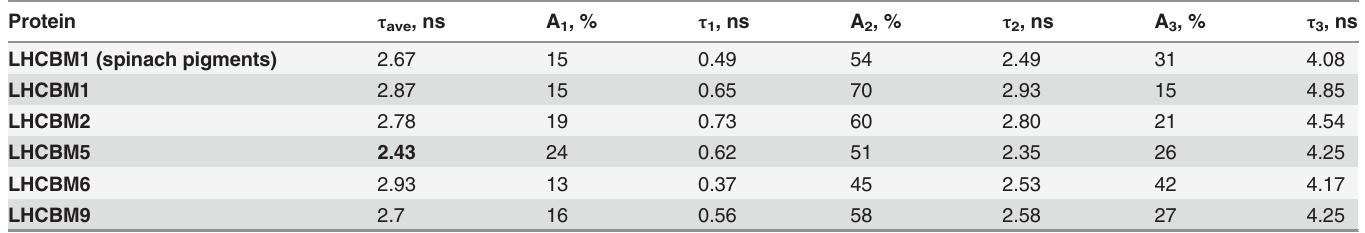
The amplitudes (A i ) of the different lifetimes (t i ) to the fl uorescence decay, and the average fl uorescence lifetime (t ave ) are